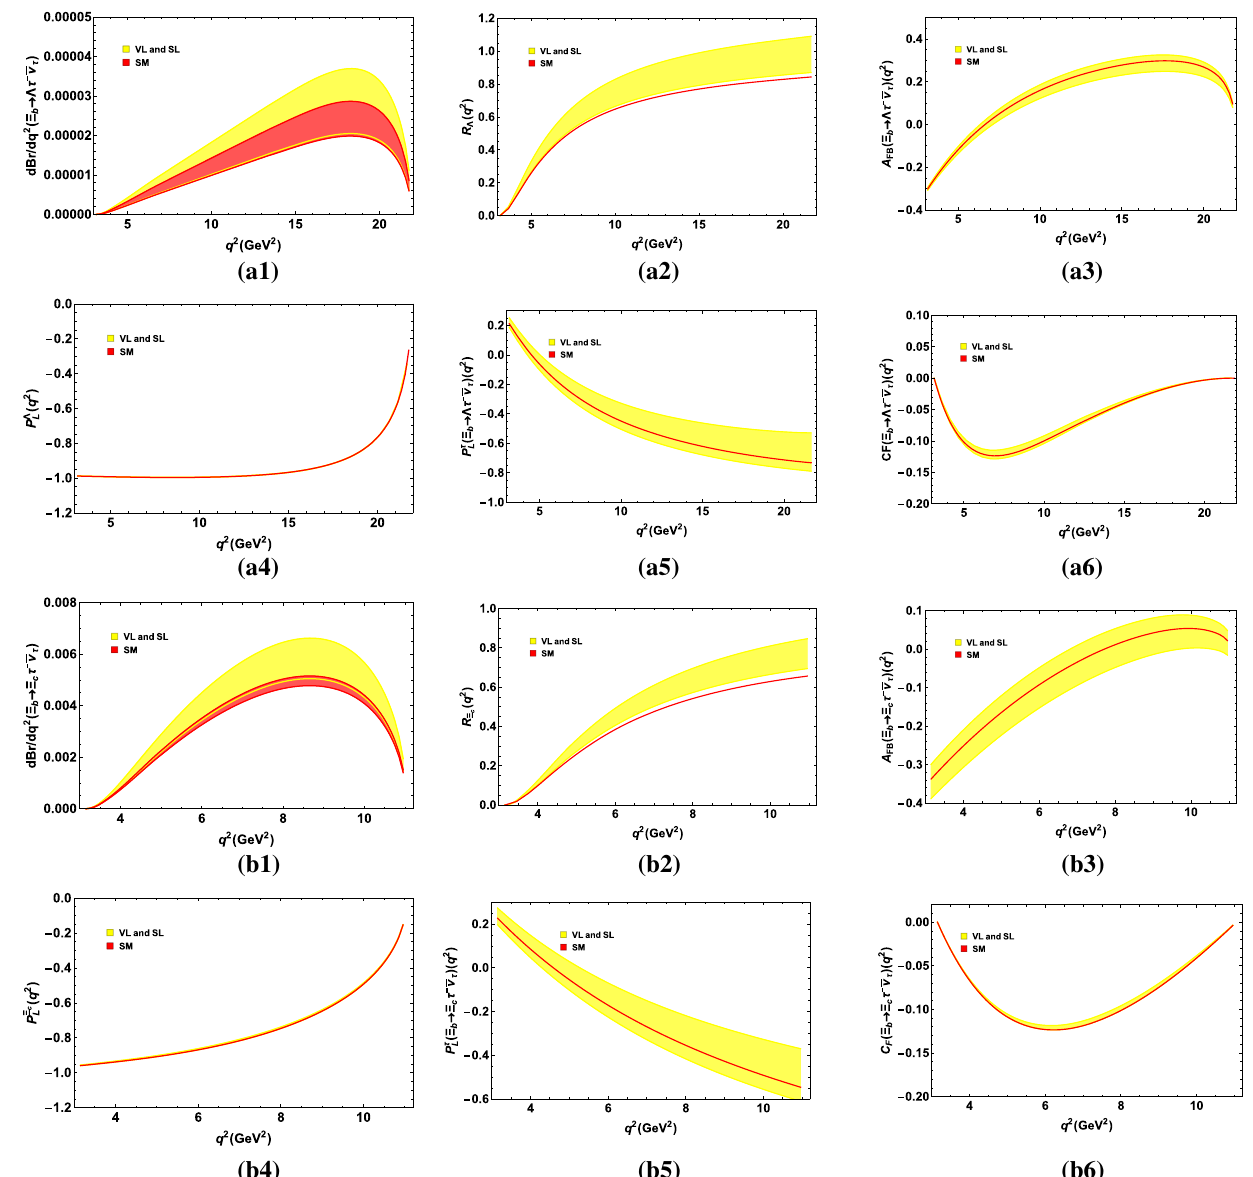
( q 2 ) ( a5 , b5 ) and C l ( q 2 ) ( a6 , b6 ) relative to the (cid:2) b4 ), P τ L F and (cid:2) b → (cid:2) c τ − ¯ ν τ decays, respectively. The bands contain the theo- (cid:3)((cid:2) c ) ( q 2 ) ( a4 , retical uncertainty of the CKM matrix elements | V u ( c ) b L